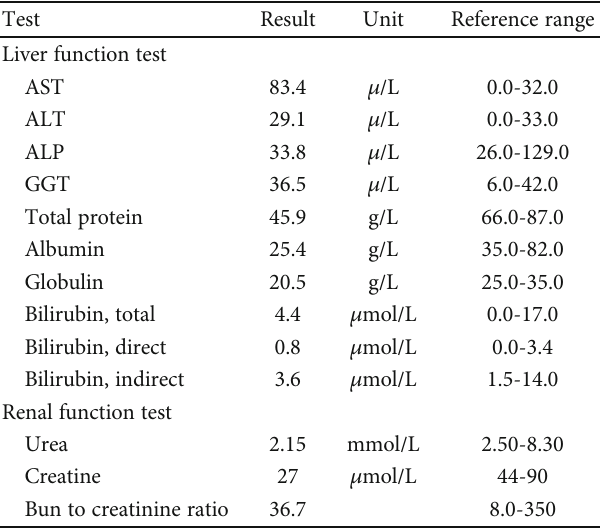
Table 1: Patient ’ s biochemical test.